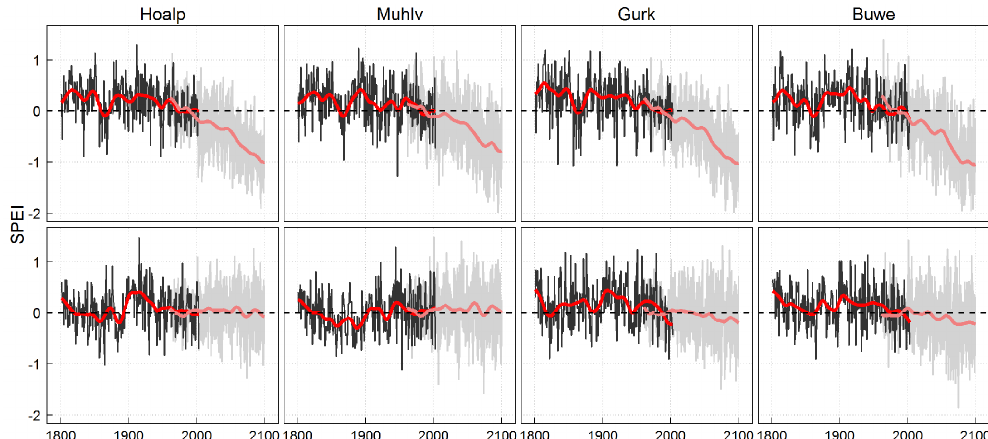
Figure 1. Standardized Precipitation Evaporation Index (SPEI) in summer (top) and winter (bottom) (3-month averages of monthly values) for the four example catchments. Observed (HISTALP, Auer et al., 2007, black) and projected (reclip:century ensemble spread, grey). Red and light red lines represent the Gaussian low-pass filtered values of the observed and projected SPEI,